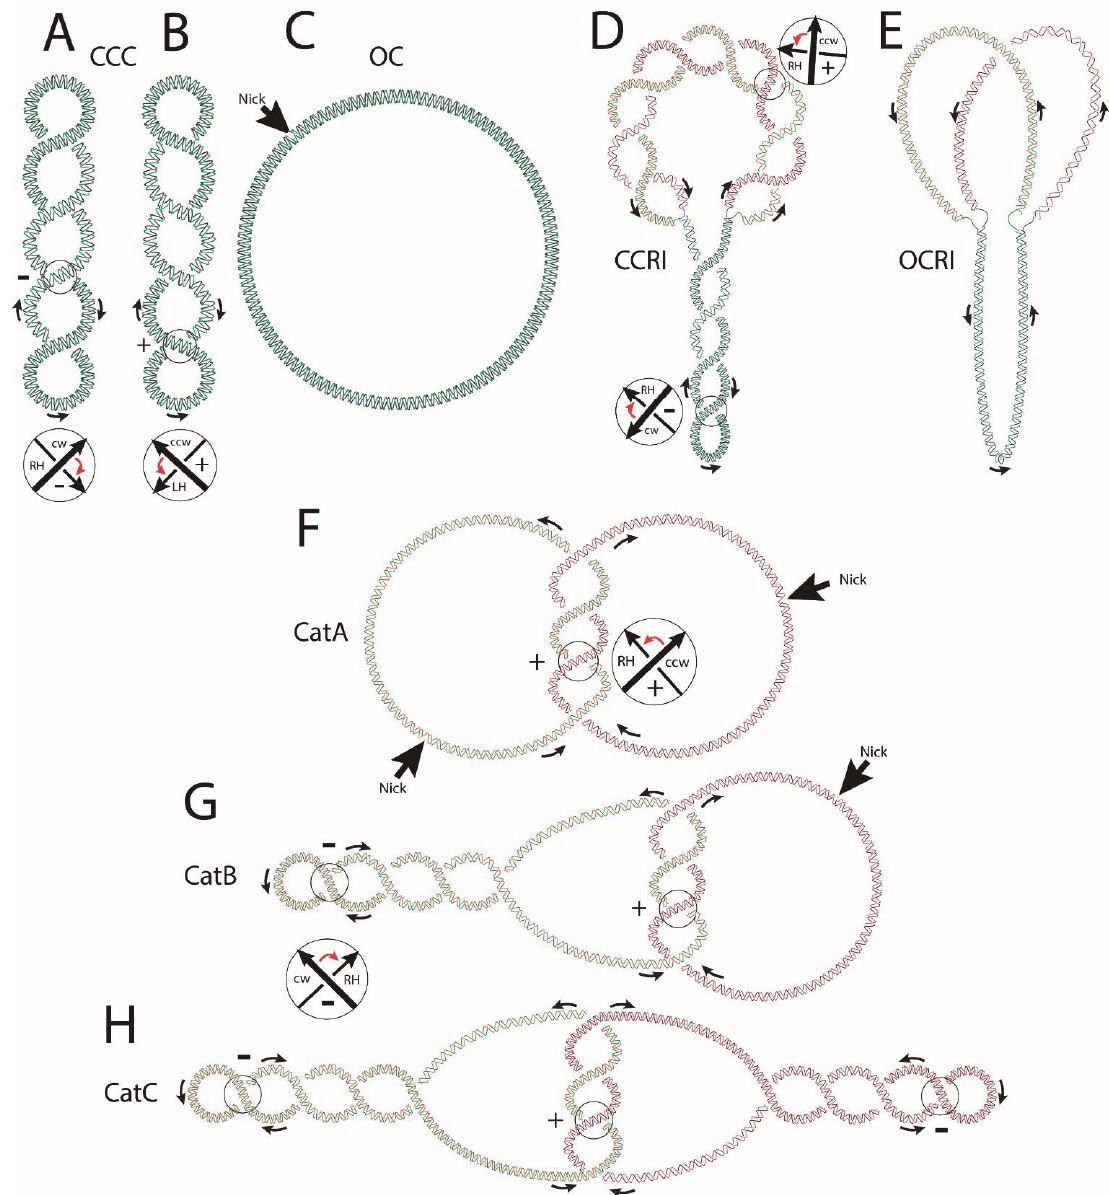
Figure 1. Cartoons illustrating some basic DNA topological features. ( A ) covalently closed circle (CCC) negatively supercoiled where the crossings between two oriented segments always have a negative ( − ) sign. ( B ) CCC positively supercoiled where the crossings between two oriented segments always have a (+) sign. The sign is determined by convention. If the direction arrow closer to the observer needs to turn clockwise to overly it with the direction arrow further from the observer, the crossing has a ( − ) sign. If the direction of turning is counter-clockwise, the crossing has a (+) sign. The turning angle cannot be larger than 180 ◦ . Notice that the orientations of the overlying and underlying direction arrows are not independent of each other but result from assigning a consistent direction (see the black arrows) to the DNA molecule analyzed. The DNA double-helix is shown in blue and green. ( C ) Introduction of a single “nick” (single-stranded breakage) causes the torsional energy of covalently-closed molecules to be completely released. After introducing a nick, negatively or positively supercoiled molecules gradually unwind until they reach their final, circular conformation and relaxed state named open-circle (OC). ( D ) covalently closed replication intermediate (CCRI) with un-replicated and replicated regions. Negative supercoiling in the un-replicated region facilitates the opening of the double-helix required for transcription and replication to begin and advance. This opening, however, generates (+) torsional tension ahead of the forks. At the beginning, when the unreplicated region is sufficiently large, several molecules of DNA gyrase and Topo IV acting